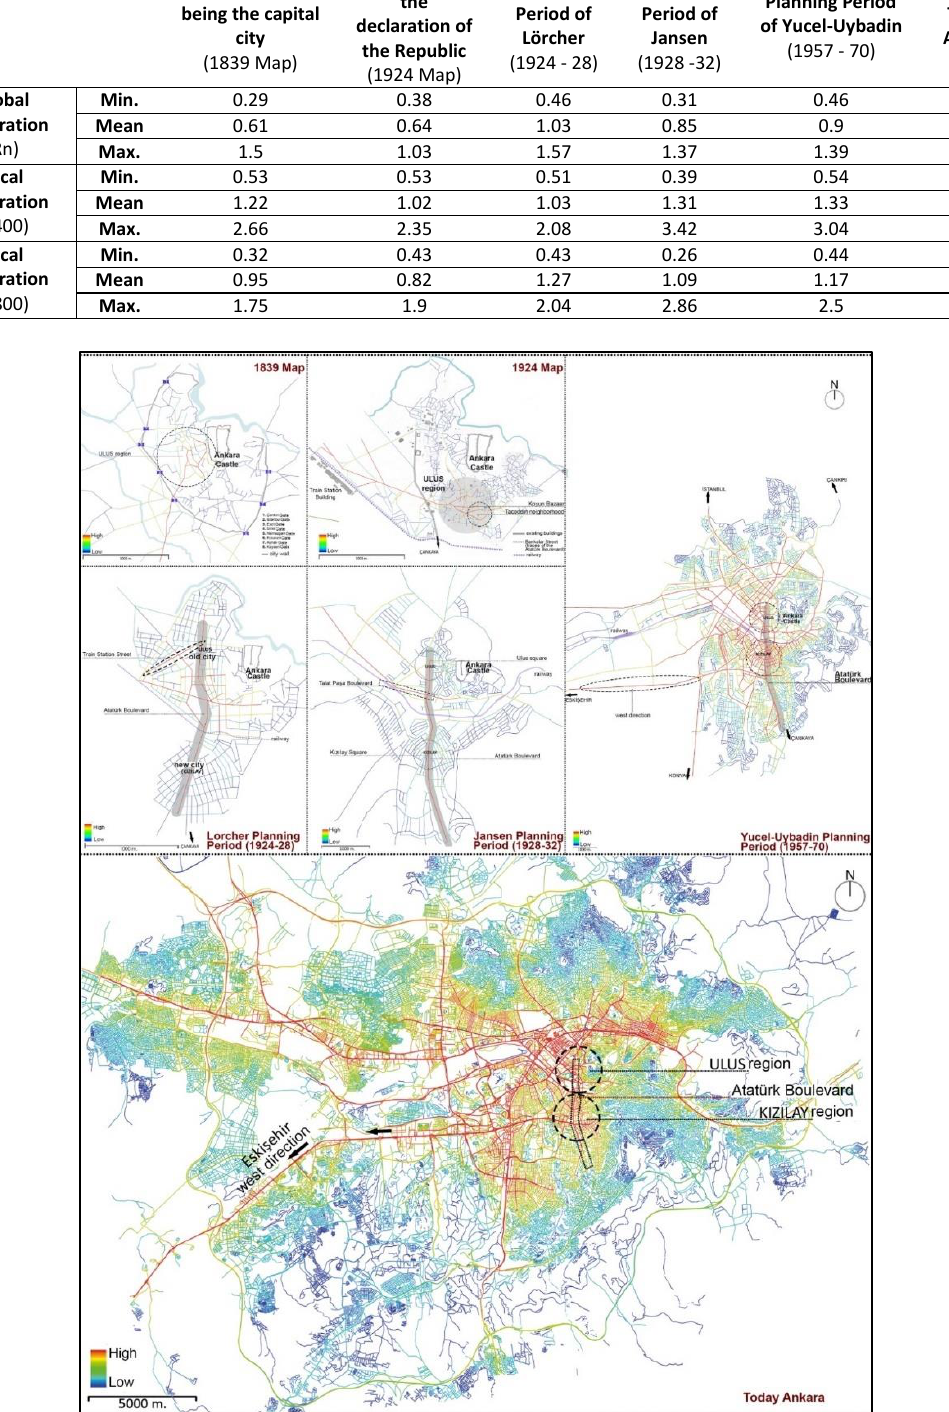
Figure 15 Global Integration (Rn)